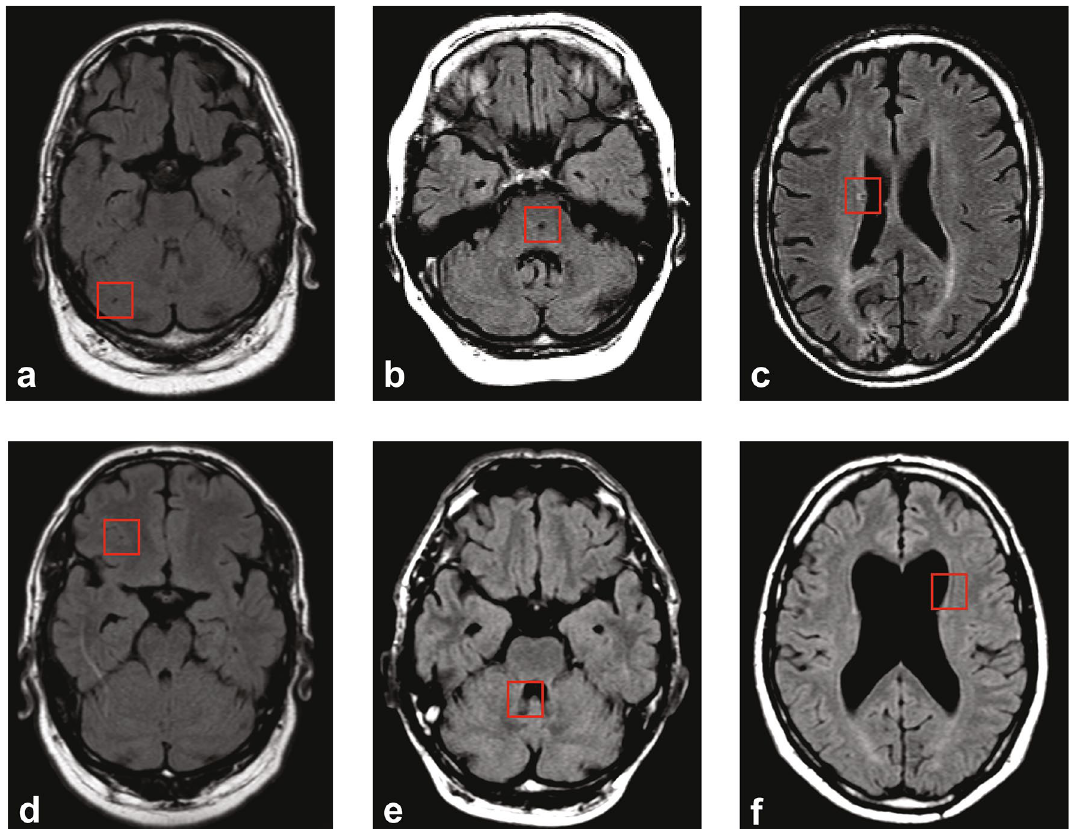
Figure 6. Comparison between missed brain infarcts and nearest neighbor locations in training images. ( a – c ) Missed brain infarcts indicated by the red square in the cerebellum, brainstem and cerebrum, respectively, on transversal T2-FLAIR images. ( d – f ) the corresponding nearest neighbor locations in training data matching ( a – c ) respectively. The square in ( d ) contains a part of a normal sulcus that has a similar appearance as the missed brain infarct in the cerebellum in ( b